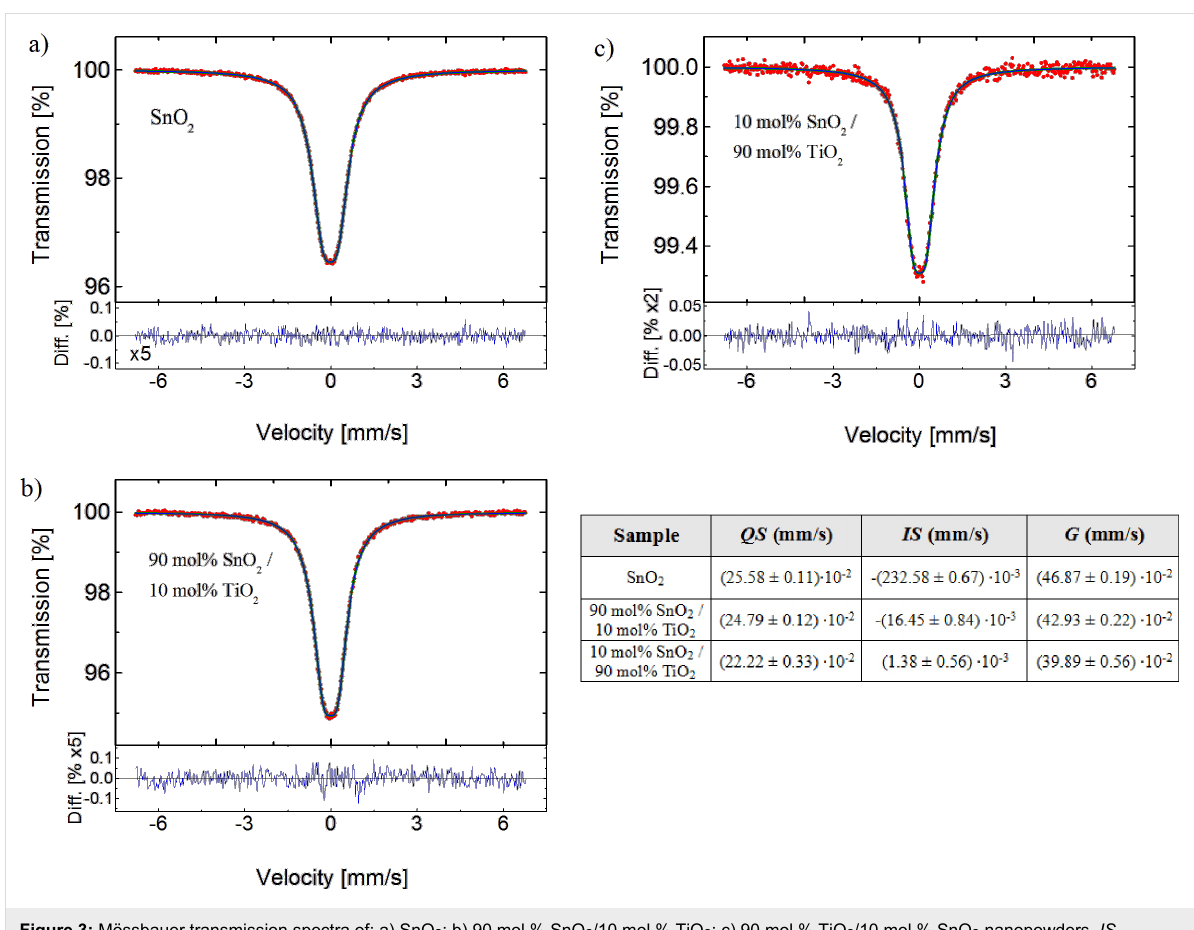
Figure 3: Mössbauer transmission spectra of: a) SnO 2 ; b) 90 mol % SnO 2 /10 mol % TiO 2 ; c) 90 mol % TiO 2 /10 mol % SnO 2 nanopowders. IS denotes the isomer shift, QS is the quadrupole splitting, whereas G represents the full width at half maximum.